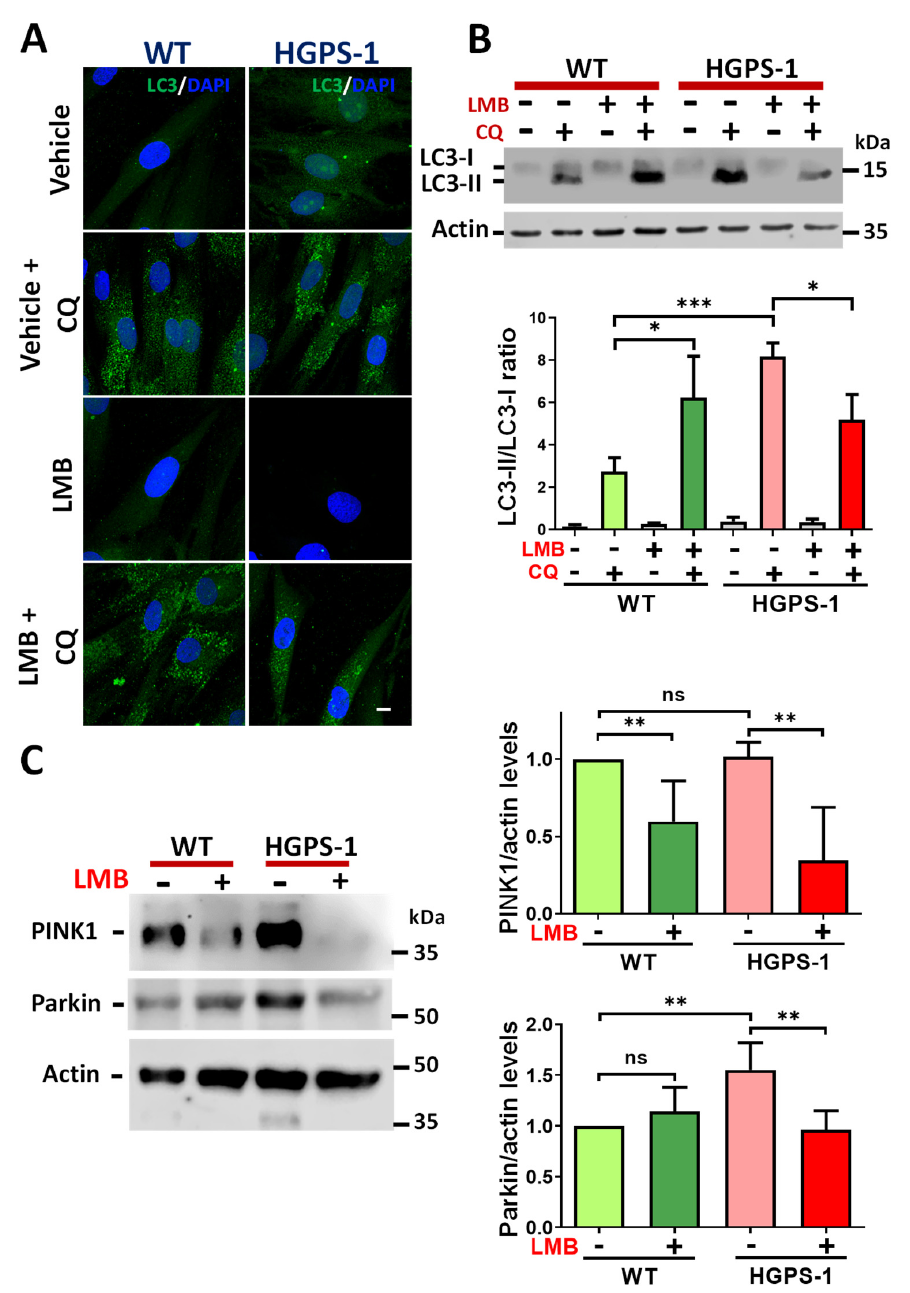
Figure 5. Mitophagy-activation in HGPS cells is mitigated upon treatment with LMB. ( A ) WT and HGPS-1 cells grown on coverslips were treated with 1 nM LMB or the vehicle alone for 3 days or further incubated with 50 µM CQ for 12 h, prior to being subjected to confocal microscope analysis using the LC3 antibody. Representative images from three independent experiments are shown. Nuclei were stained with DAPI; scale bar 10 µm. ( B ) Lysates from WT and HGPS-1 cells treated with LMB and/or with CQ, as in panel A, were analyzed by Western blotting using specific antibod- ies against LC3 and actin (loading control). Bottom . Quantification of the LC3-II/LC3-I ratio is shown. Data correspond to the mean +/ − SD of three independent experiments, with p values denoting sig- nificant differences (unpaired t test; * p < 0.05; *** p < 0.001). ( C ) PINK1 and parkin levels of WT and HGPS-1 cells, previously treated as in panel A, were analyzed by Western blotting using actin as a loading control. Right. The levels of PINK1 and parkin were assessed in WT and HGPS-1 cells and graphed. Data represents the mean +/ − SD of three separate experiments, with p values referring to statistically significant differences (unpaired t test; ** p < 0.01); ns, no significance.